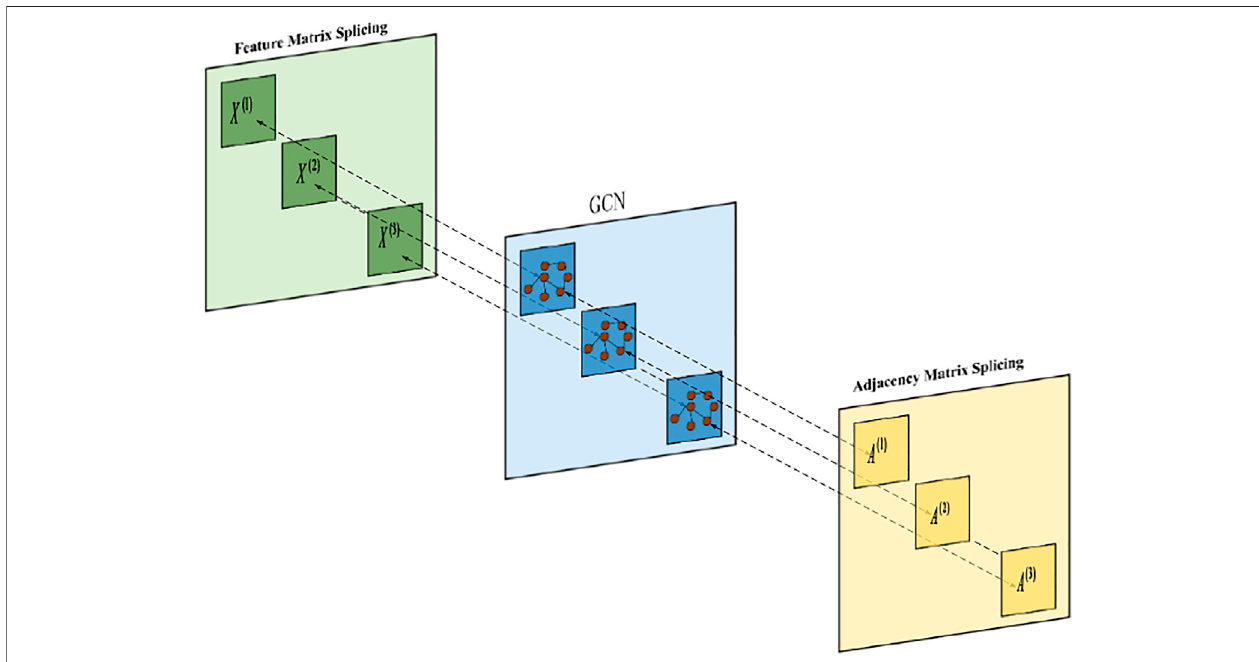
FIGURE 6 | Graph concatenation for parallel